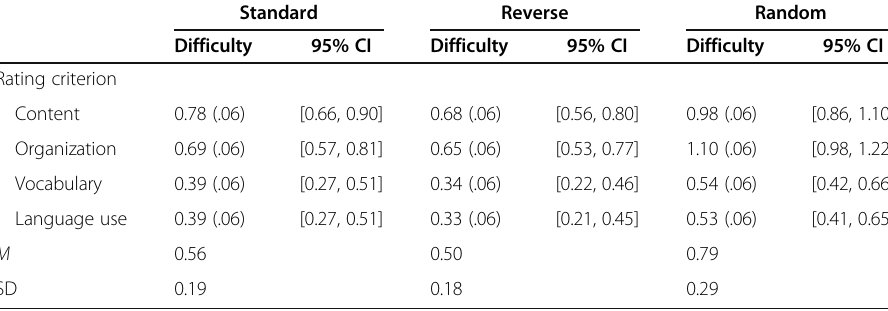
Table 12 Rasch summary statistics of rating criterion